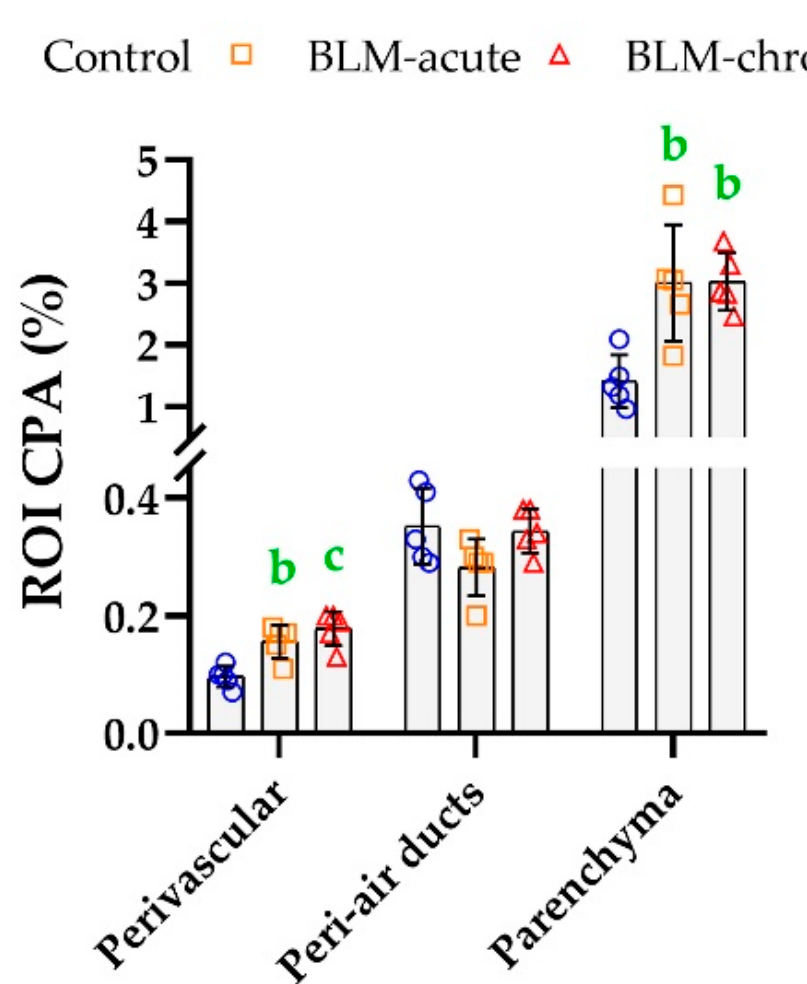
Figure 7. Lung ROI CPA calculated for each ROI using the PSR OPT detection method. Mean ( ± SD) and one-way ANOVA with Fisher’s post-hoc test. a: p < 0.050, b: p < 0.010, c: p < 0.001 vs. controls.